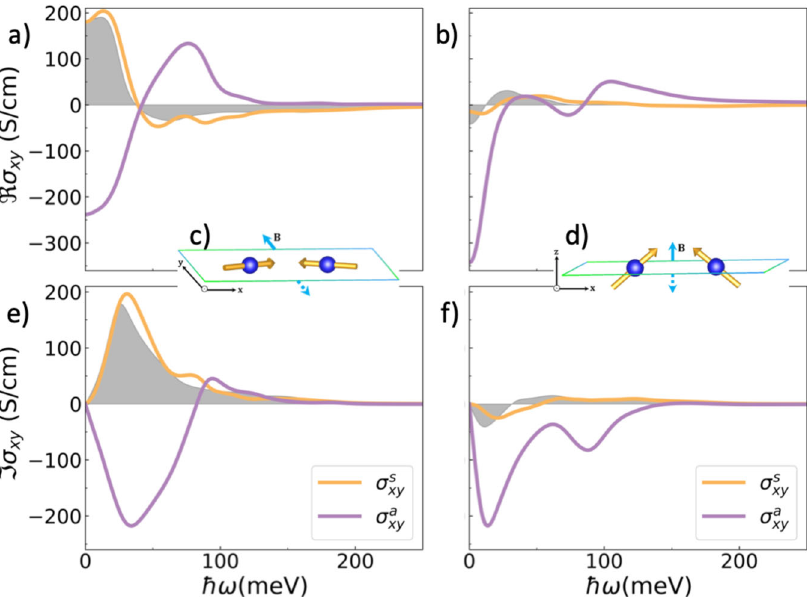
Fig. 6 Chiral magneto-optical effect in monolayer of antiferromagnetic SrRuO 3 . ( a , e ) Real and imaginary part of the magneto-optical conductivity in the collinear state (gray shaded area) as well as its symmetric and antisymmetric parts for 5 ∘ spin canting in the xy -plane evaluated for the position of the Fermi energy at E F = 1.05 eV. ( b , f ) Same as in ( a , e ) but for the xz -plane of canting evaluated at E F = 1.01 eV. The sketches depict the canting of the spins in antiferromagnetic SRO monolayer upon an application of an external magnetic fi eld along the ± y -axis c , and ± z -axis d